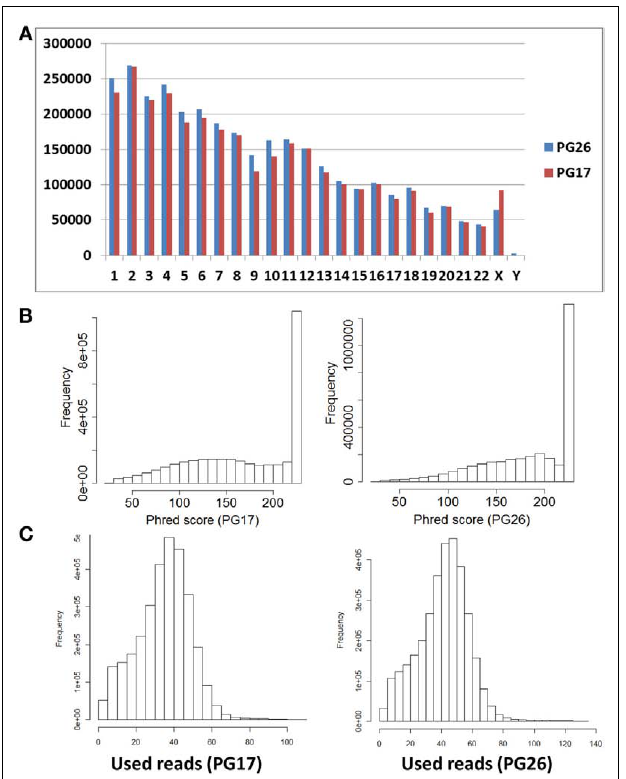
FIGUREA2 | (A) Number of SNPs called by both SNP callers, the CASAVA algorithm and SAMTools, with > 99% concordant genotype calls, by chromosome. (B) Distribution of Phred scores in SNPs called in PG17 and PG26 (From SAMTools). (C) Distribution of reads used for SNPs calling in PG17 and PG26 (From CASAVA).The median number of used reads was 36 in PG17 and 43 in